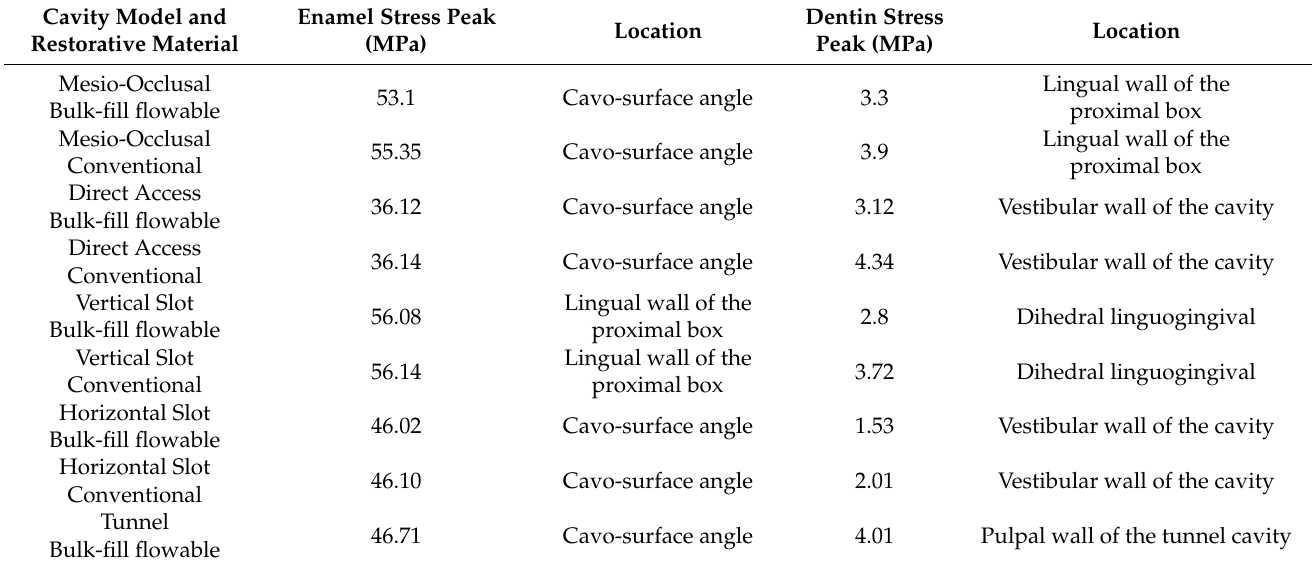
Table 4. Stress peaks (MPa) during polymerization shrinkage and loading effect measured in enamel and dentin tissue and the respective locations in the